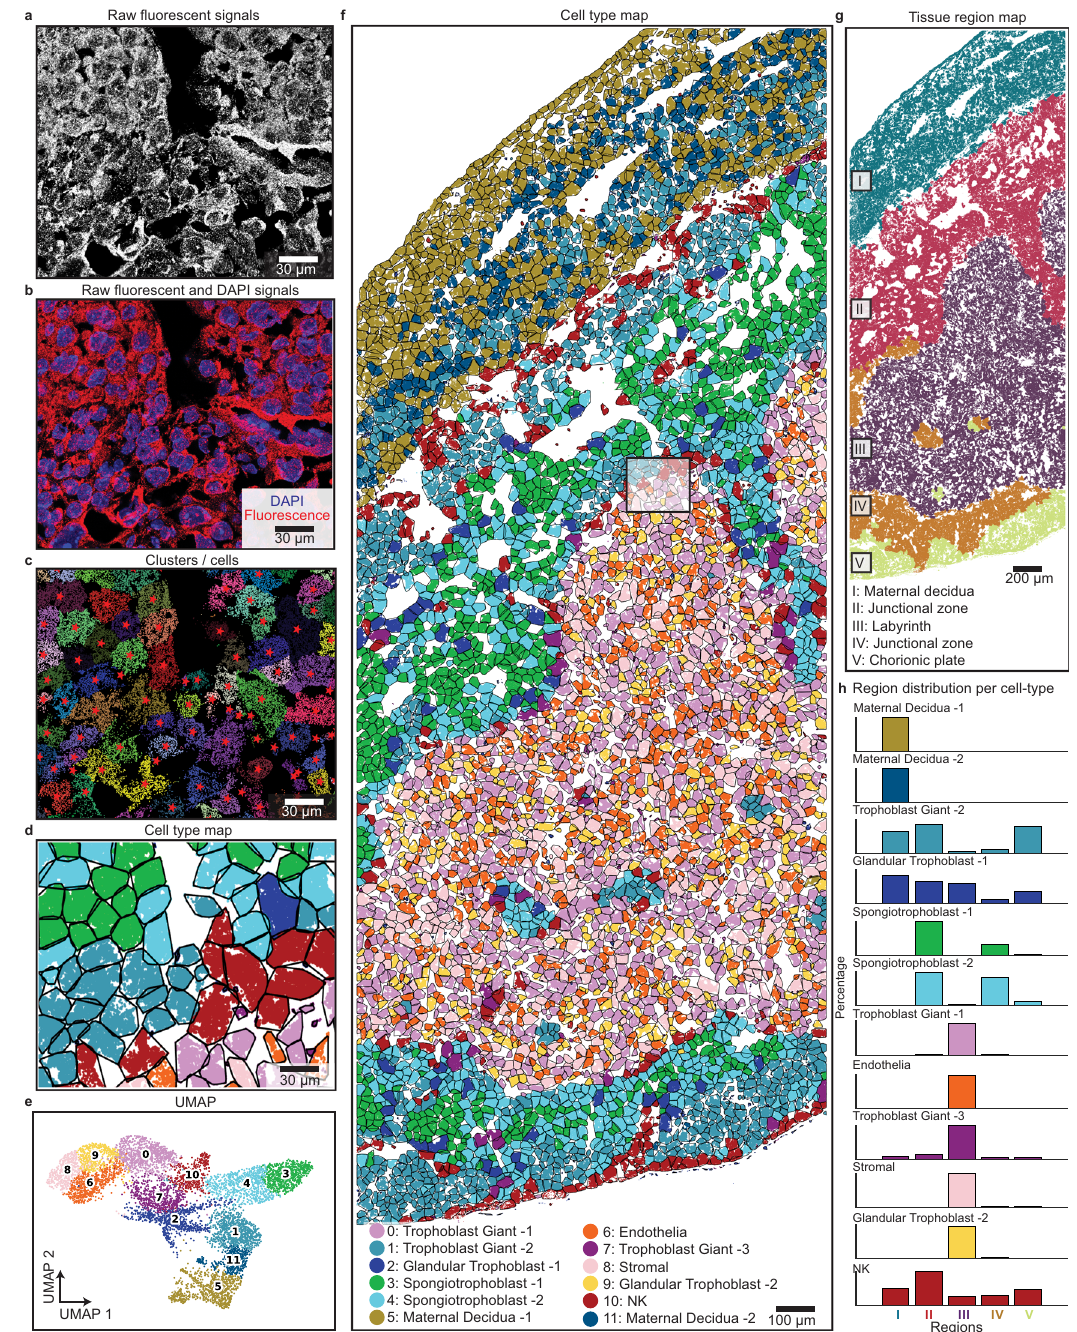
2: Glandular Trophoblast -1 3: Spongiotrophoblast -1 4: Spongiotrophoblast -2 5: Maternal Decidua -1 Fig. 3 ClusterMap generates cell-type and tissue-region maps in mouse placenta. a Raw fl uorescent signals for a part in the STARmap mouse placenta 903-gene dataset 6 . Four-channel images in the fi rst sequencing round are overlapped in grayscale to show the mRNA distribution. b Composite image by overlapping ( a ) in red and DAPI signals in blue shows the distribution of mRNA relative to cell nuclei. A majority of mRNA molecules distributed outside the cell nucleus, resulting in holes in the cell center. c , d ClusterMap generates cell segmentation map ( c ) and cell-type map ( d ) of ( a ). Panels a – d show the zoomed-in view from the highlighted rectangle in f , the original dataset. e Uniform manifold approximation plot (UMAP) shows clustering of 11 groups across 7224 cells in the original placental dataset. f Spatial organization of the cell types in the placental tissue section. The number of cells in each type is as follows: Trophoblast Giant-1 (TG-1), 848; Endothelial (Endo), 578; Stromal (Stro), 418; Trophoblast Giant-2 (TG-2), 833; Maternal Decidua-1 (MD-1), 735; Glandular Trophoblast-1 (GT-1), 717; Spongiotrophoblast-1 (ST-1), 697; Spongiotrophoblast-2 (ST-2), 680; Trophoblast Giant-3 (TG-3), 544; Glandular Trophoblast-2 (GT-2), 410; NK, 404; Maternal Decidua-2 (MD-2), 360. g The spatial tissue region map of f . h Bar plots of composition of 12 cell types across 5 regions. Values are normalized in each row. Cell types in f , h are color-coded as in e